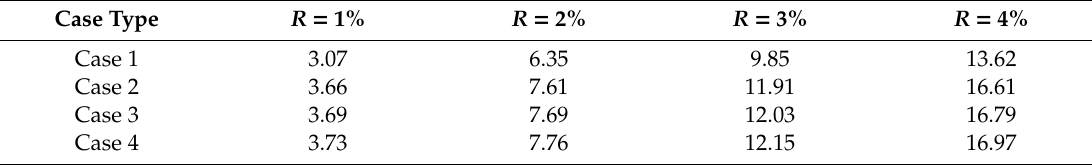
Table 6. Payback period for every alternative with di ff erent equivalent continuous discount